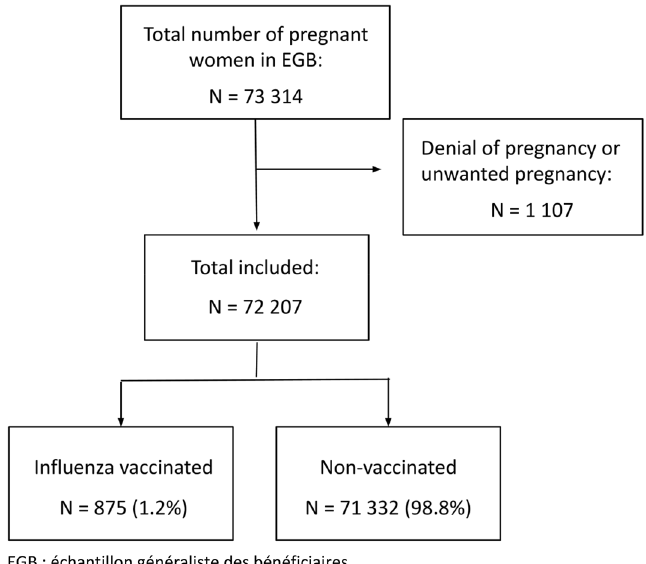
Figure 2. Flow chart of the study.